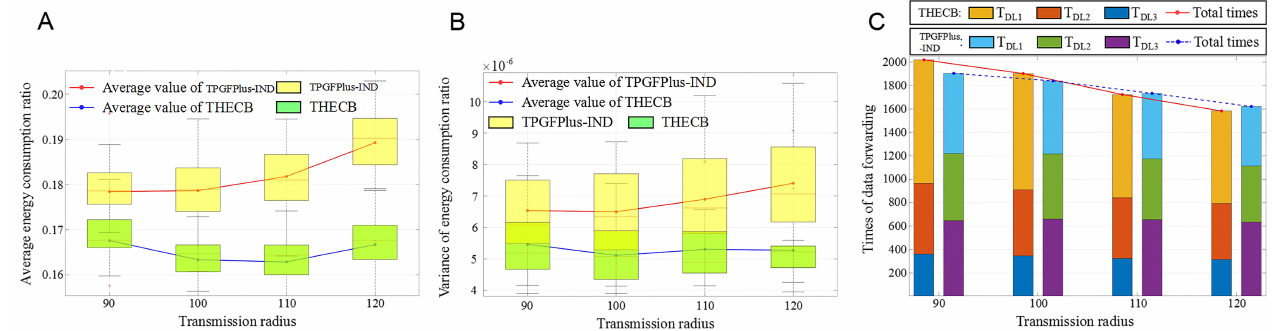
Figure 17. The performance of these algorithms with varied transmission radius. ( A ) Total energy consumption ratio. ( B ) Variance of energy consumption ratio. ( C ) The times of participating in data forwarding.